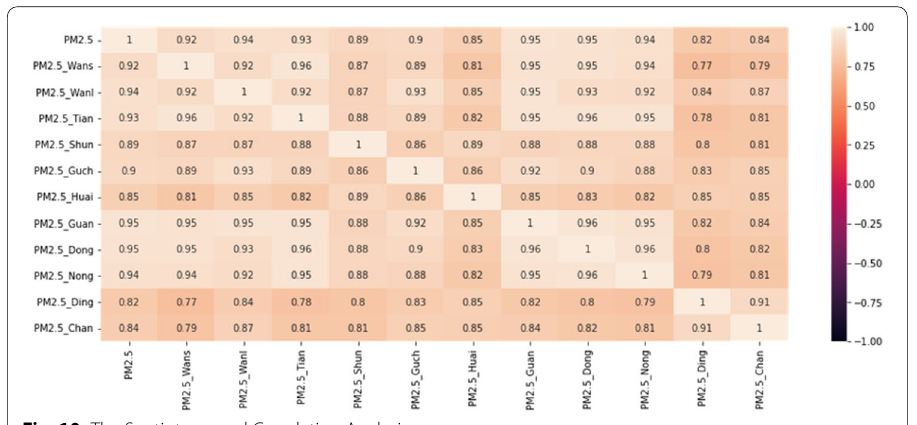
Fig. 10 The Spatiotemporal Correlation